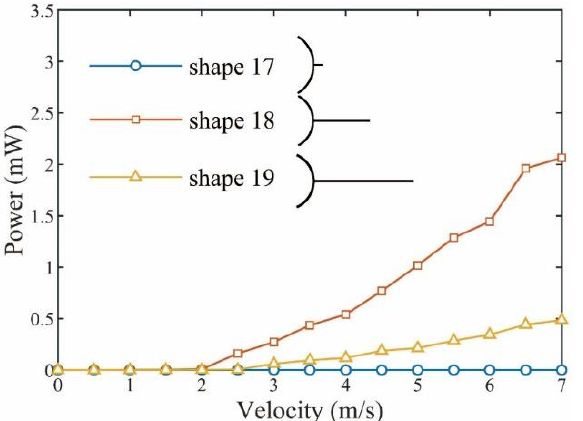
Figure 8. Variation of output power with wind velocity for WEHs with different tail lengths bluff bodies.